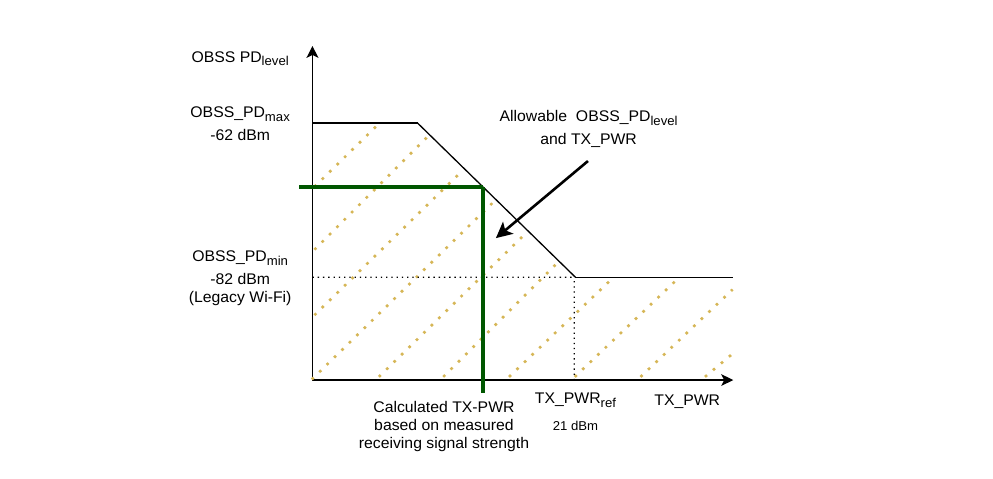
Figure 13. OBSS PD: A station’s inter-BSS NAV is updated only if the RSSI of an inter-BSS packet is larger than the OBSS _ PD level . Otherwise, the station can perform a concurrent transmission with a transmission power that can be derived from this diagram when the OBSS _ PD level is